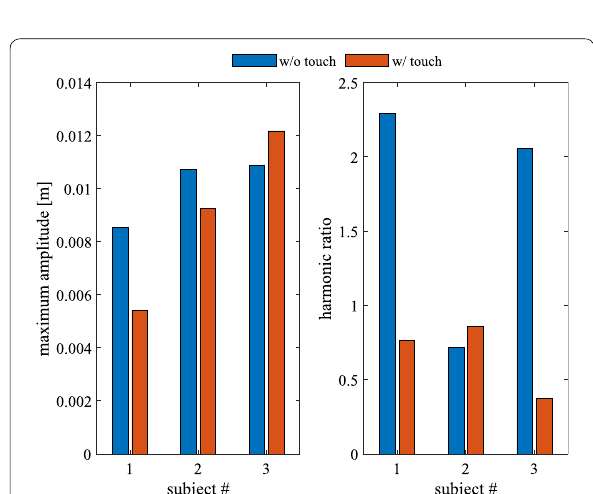
Fig. 13 Maximum amplitude and harmonic ratios of the sacrum positions of each subject in y-axis. The left figure shows the maximum amplitudes of the subjects’ sacrum at the frequencies of the trials, and the right one shows their harmonic ratio in y-axis (frontal direction). The maximum amplitudes of the two subjects decreased. On the other hand, the harmonic ratio of one subject slightly